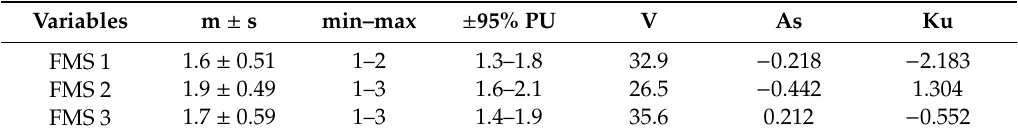
Table 3. Characteristics of the results of the functional status of movement patterns carried out prior to the start of the